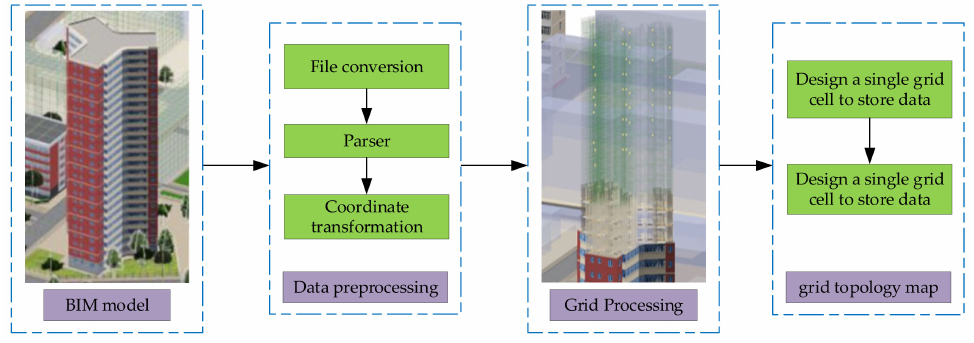
Figure 5. Indoor grid map construction process.